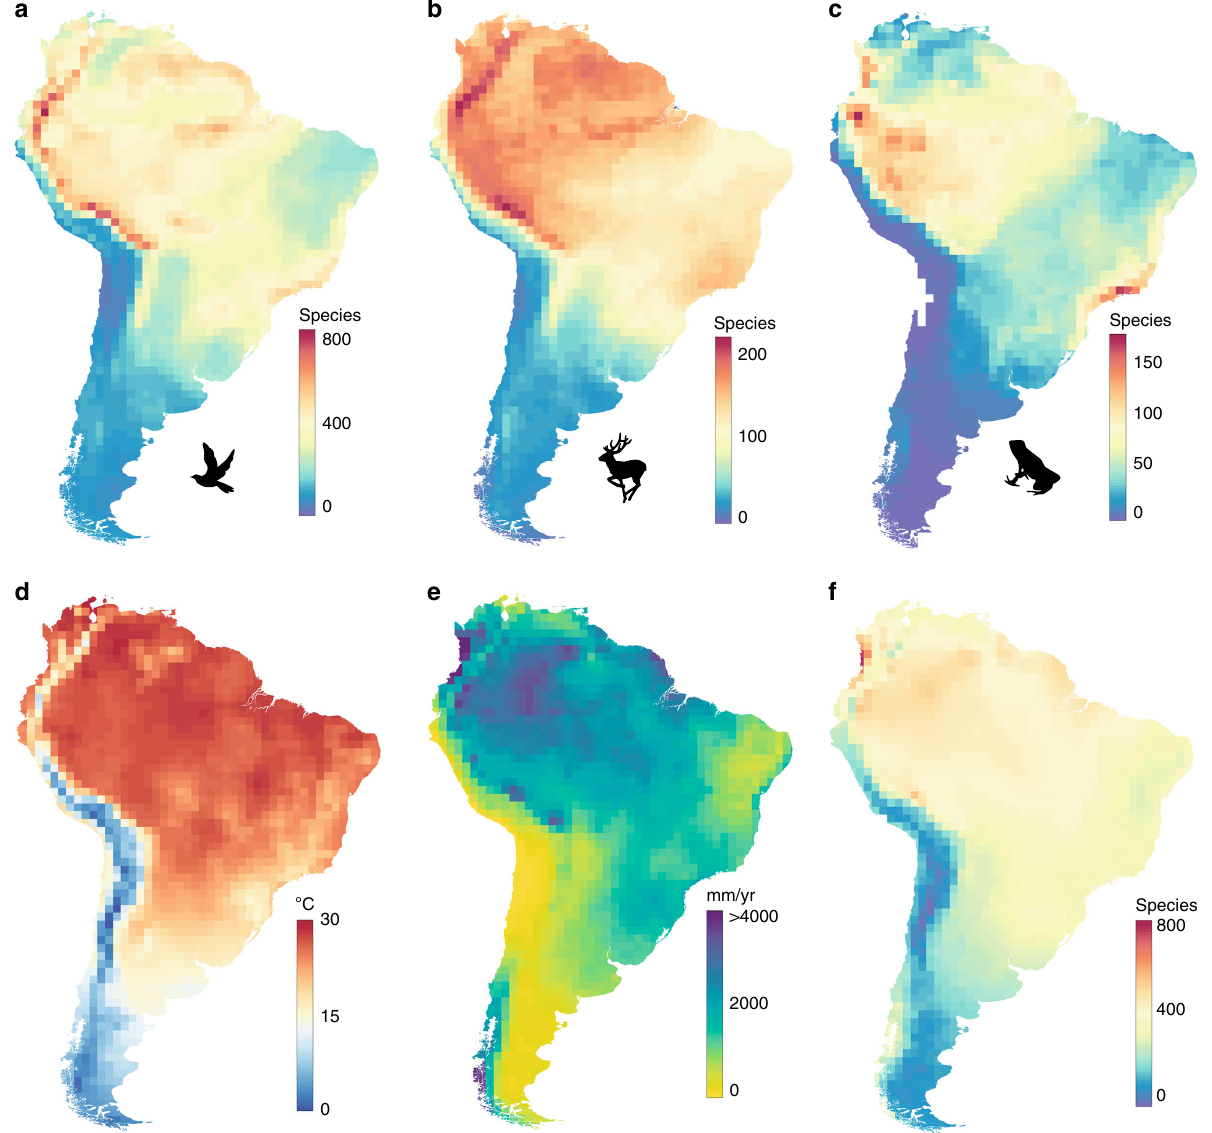
Fig. 1 Species richness and environmental variables in South America mapped in 1° × 1° grid cells. a Species richness of birds ( n = 2869), b mammals ( n = 1146), and c amphibians ( n = 2265). d Mean annual temperature (°C). e Annual precipitation (mm). f Predicted richness of birds based on a linear model of temperature and precipitation ( R 2 =